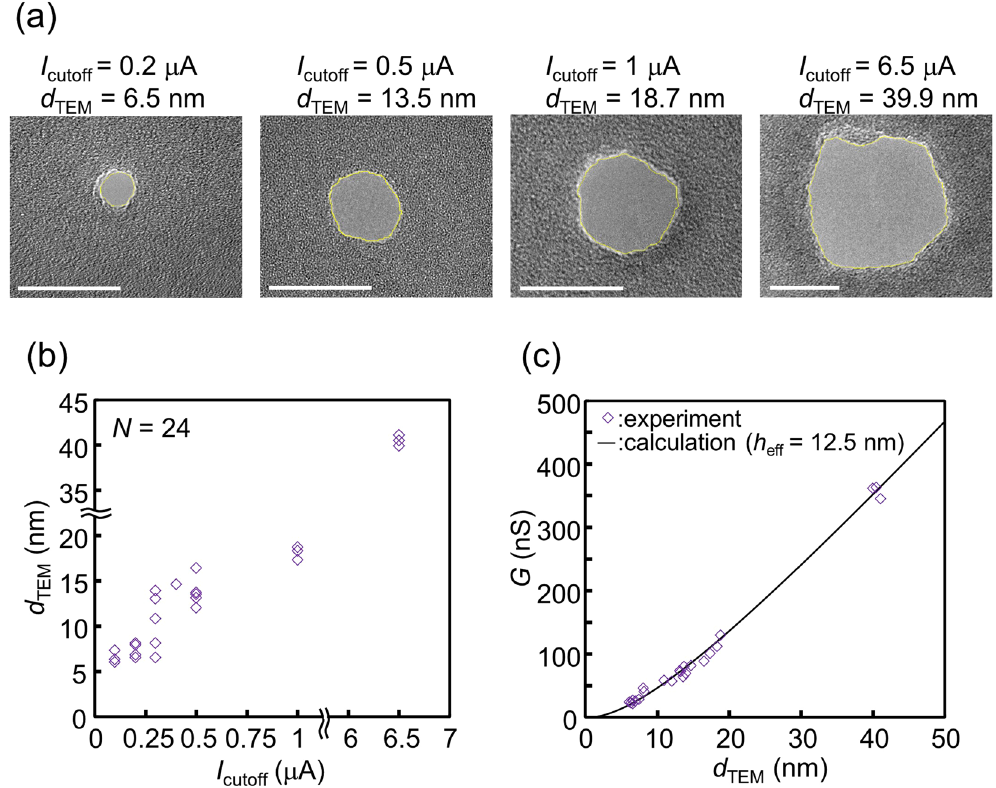
Figure 5. Dependence of the size of the fabricated nanopores on I cutoff . Nanopores were fabricated in 20-nm- thick SiN membranes by CBD at a pH of 12.7 with various I cutoff values. V cis and V trans were set at 18 V and 0 V during CBD, respectively. ( a ) TEM images of the fabricated nanopores. Scale bars are 20 nm. The areas of the nanopores are surrounded by yellow lines. ( b ) Dependence of the equivalent diameter ( d TEM ) of the fabricated nanopores on I cutoff . ( c ) Relationship between conductance ( G ) of ionic current through the fabricated nanopores and d TEM . The solid line represents theoretically calculated